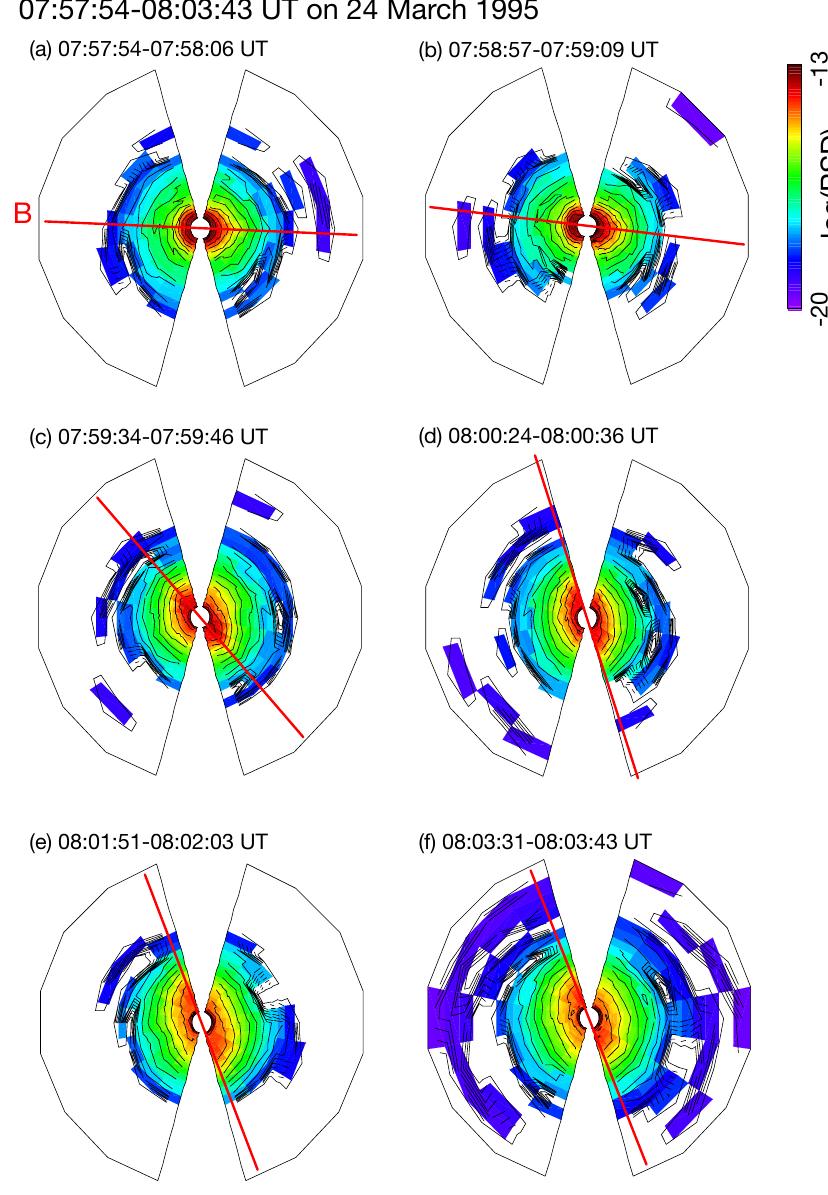
Fig. 7. 2-D cuts of the electron velocity distribution functions, which correspond to the ion distribution functions shown in Fig. 5.